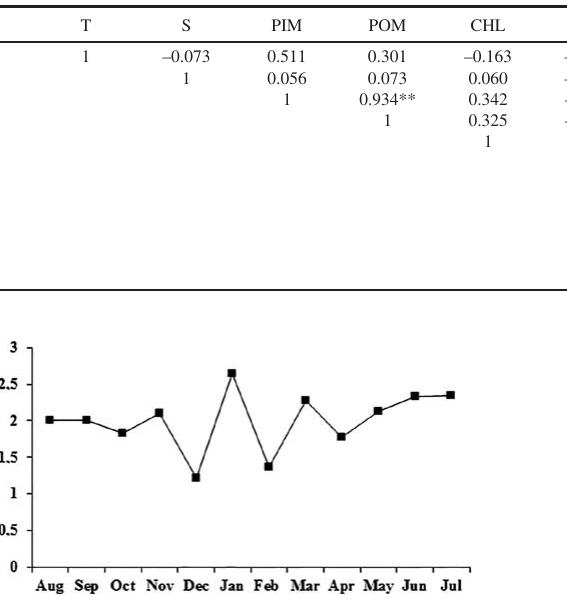
Fig. 8. – Variation of gonad index (GI) in Ostrea edulis from August 2008 to July